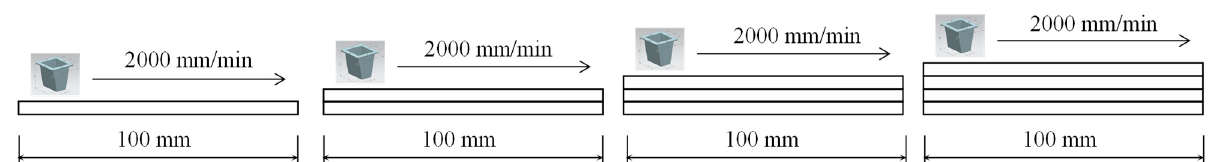
Figure 11. Relationship between spindle shaft rotation speed and printing mass per min. After four layers and three rows were printed, the print quality was evaluated. Qual- itative print quality was evaluated by examining the surface defects, deformation degree, and dimensional consistency of the top layer of the deposited part [33]. Quantitative print- ability and buildability, such as changes in the width and height of a deposited part com- pared to the designed values, were not evaluated. This is because the interlayer time in- terval and appropriate printing material properties, such as the initial yield stress and elastic modulus, were not determined considering the size of the target structure. There- fore, the deformation of the lower layer due to the deposition of the upper layer was in- evitably large, which had a significant influence on the change in the width and height of the entire deposited part. Moreover, a standardized method for quantitatively evaluating the print quality is not available worldwide. A specimen was manufactured to measure the density and compressive strength by coring the deposited parts prior to hardening. As shown in Figure 12, a cylindrical coated paper mold with a diameter of 50 mm and a height of 100 mm, with both open top and bottom surfaces was vertically inserted into the deposited parts at approximately 30 min. After the deposited parts were made, and the remaining samples outside the mold were removed to separate the six specimens. Specimens manufactured in air were cured in air for 2 days with plastic sheets covered, and after demolding, they were placed in curing water. In the case of specimens manufactured underwater, after separating the specimens